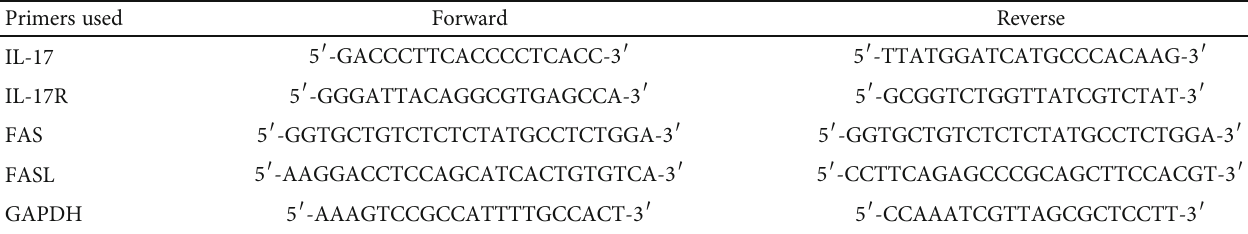
Table 1: Primer sequences of IL-17, IL-17R, FAS, FASL, and